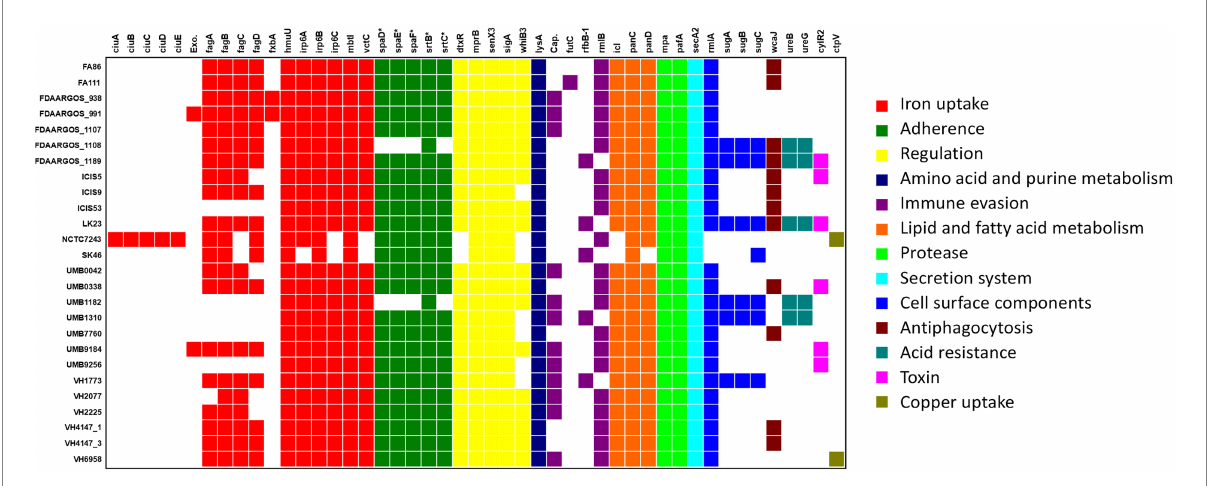
FIGURE 7 Distribution of virulence factors throughout the C. amycolatum genomic sequences. According to the legend, colors indicate the functional classes of the identified genes. Exo = exochelin coding sequence (ortholog to M. smegmatis gene); Cap = capsule related gene (ortholog to Acinetobacter spp). * Denotes gene sequences annotated by manual curation after automatic